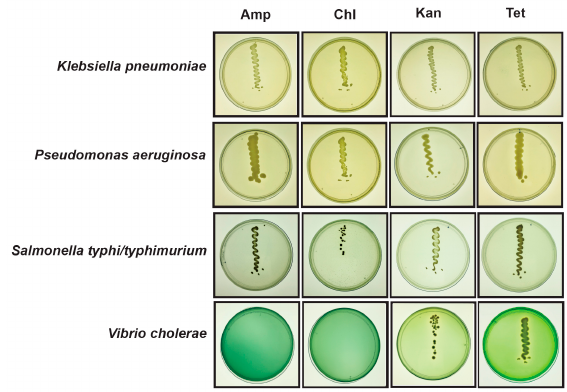
Figure 3. In vitro evaluation of antimicrobial resistance of pathogenic bacterial species isolated from flooded sites (August 2018). The culture plates showing pathogenic bacteria ( Klebsiella pneumoniae, Pseudomonas aeruginosa, Salmonella typhi/typhimurium , Vibrio cholerae) streaked on selective/differential agar media (HiCrome TM Klebsiella selective agar base, Cetrimide agar base, Wilson Blair agar with brilliant green (w/BG), Thiosulphate-Citrate-Bile-Salt sucrose (TCBS) agar, respectively) containing different antibiotics such as Amp: Ampicillin (100 µg/mL), Kan: Kanamycin (50 µg/mL), Chl: Chloramphenicol (25 µg/mL), Tet: Tetracycline (10 µg/mL), and incubated at 37 °C for 1–3 days.